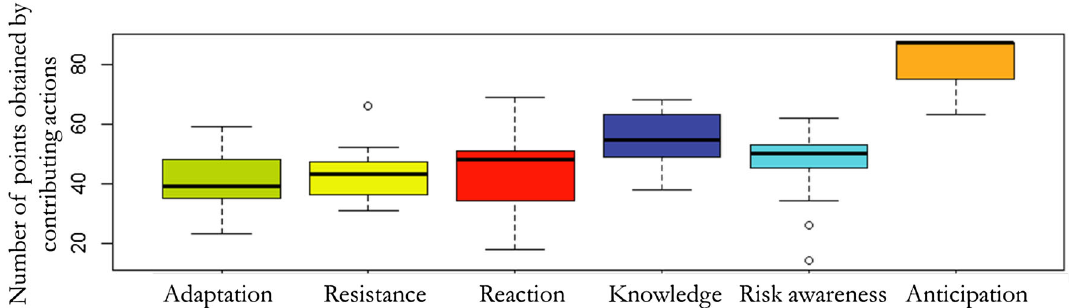
Fig. 5 Boxplots of the points obtained from the contributing codes for each strategy for managing vulnerability to flooding. Source : Adapted from Guillier (2017)